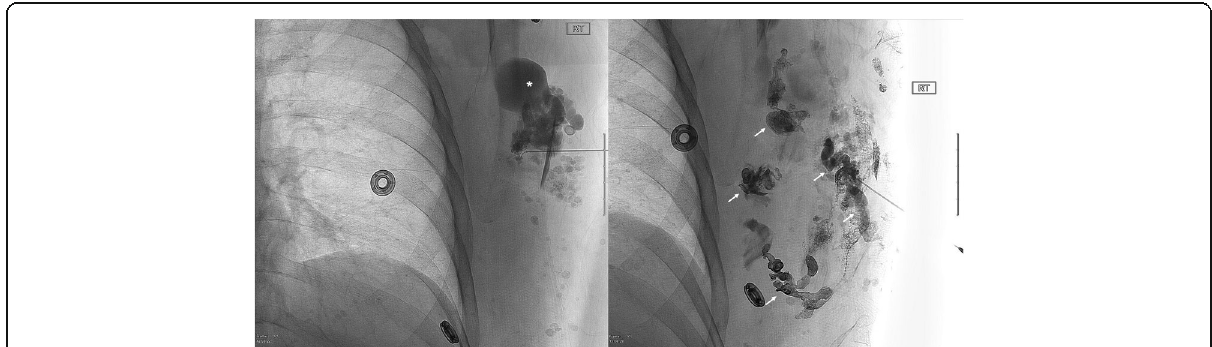
Fig. 5 a 61year-old male presented with swelling involving the right shoulder, and pectoral region secondary to VM. Fluoroscopic image demonstrates a large VM (asterisk). b . Fluoroscopy image after percutaneous embolization shows filling of venous lakes in the VM by embolic agents